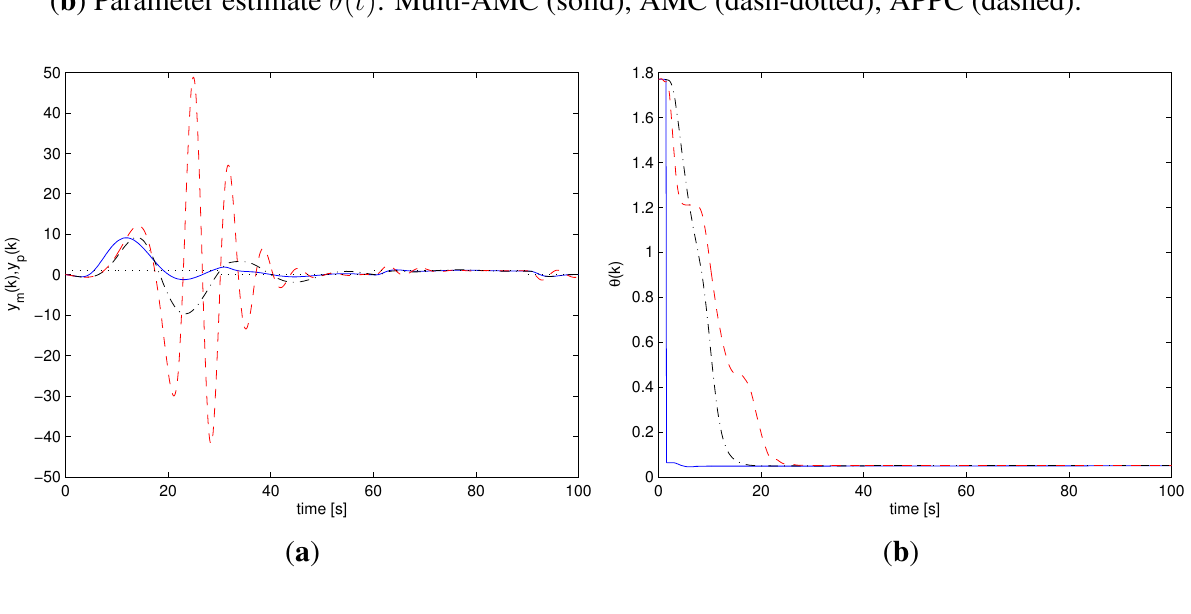
Figure 4. Ideal case, θ ∗ = 0 . 05 : Multi-AMC (solid), AMC (dash-dotted), APPC (dashed). ( a ) output response y ( t ) : Multi-AMC (solid), AMC (dash-dotted), APPC (dashed); ( b ) Parameter estimate θ ( t ) : Multi-AMC (solid), AMC (dash-dotted), APPC (dashed).